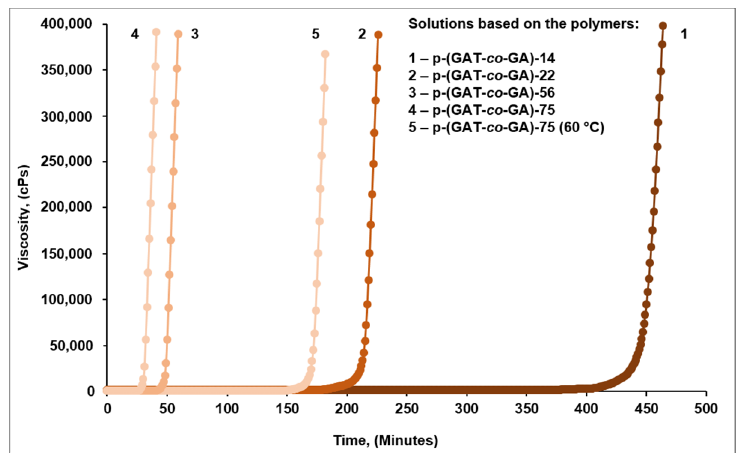
Figure 7. A time course of the viscosity of solutions based on p ‐ (GAT ‐ co ‐ GA) copolymers when cured at 80 °C (60 °C) (a constant shear rate of 0.05 s − 1 ).